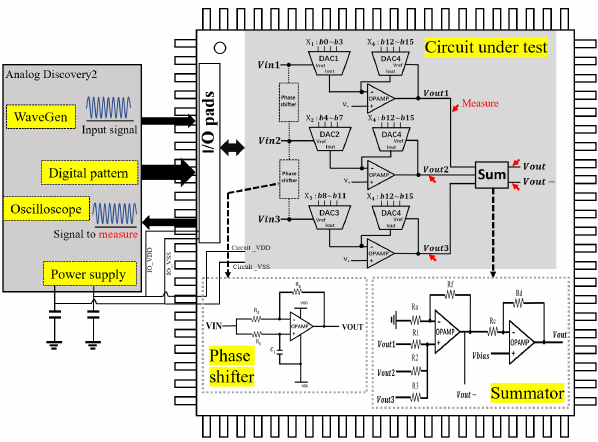
Figure 4. A schematic of a perceptron chip and block diagram of the